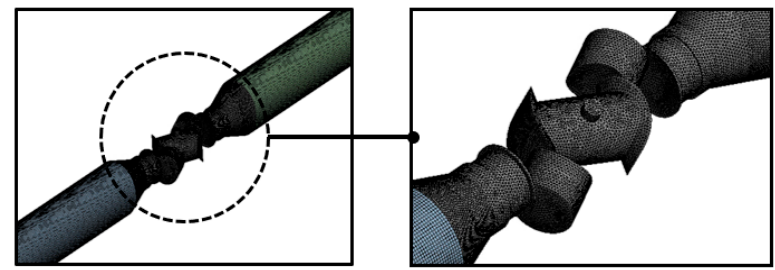
Figure 3. Features of the finite element model.